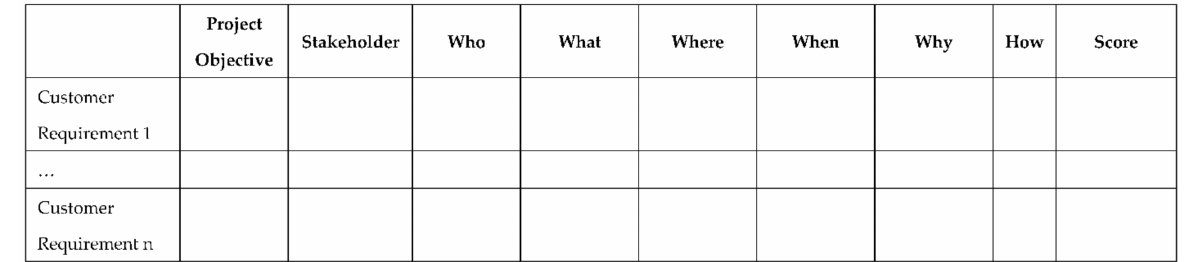
Figure 2. Grid for capturing customer requirements, see main text for description of fields.